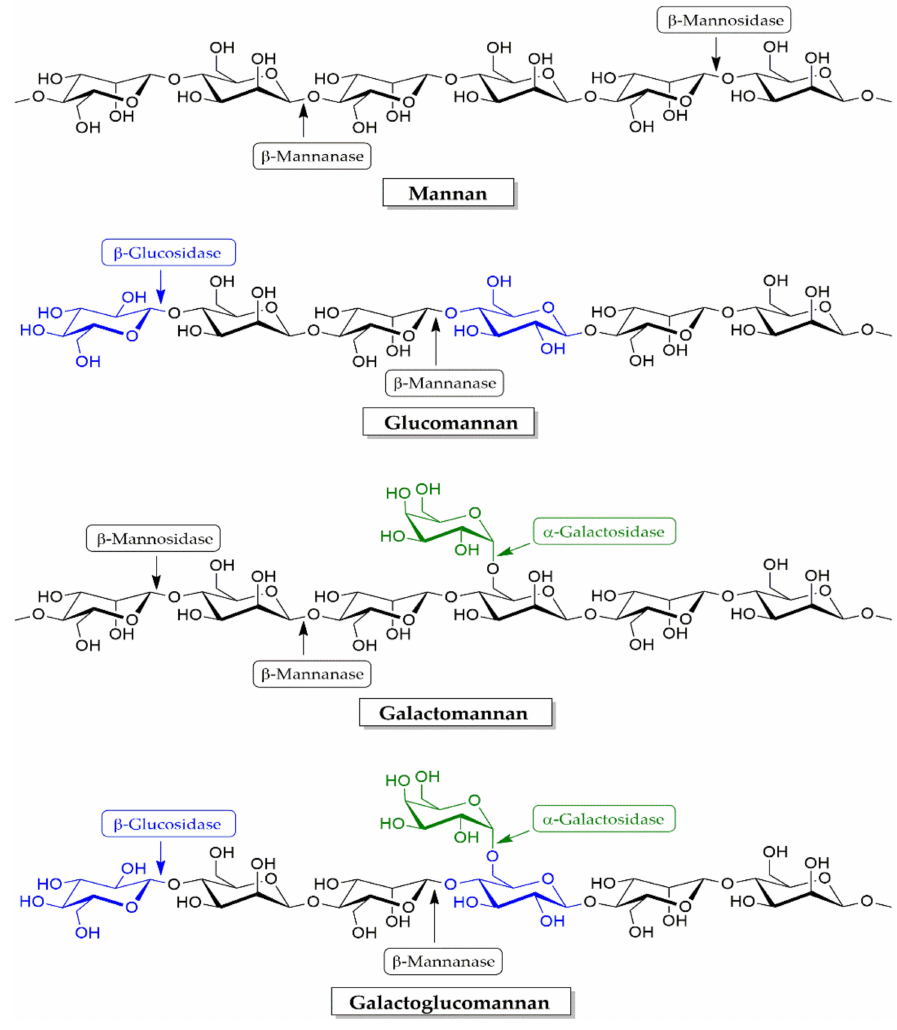
Figure 7. Enzymes involved in mannan